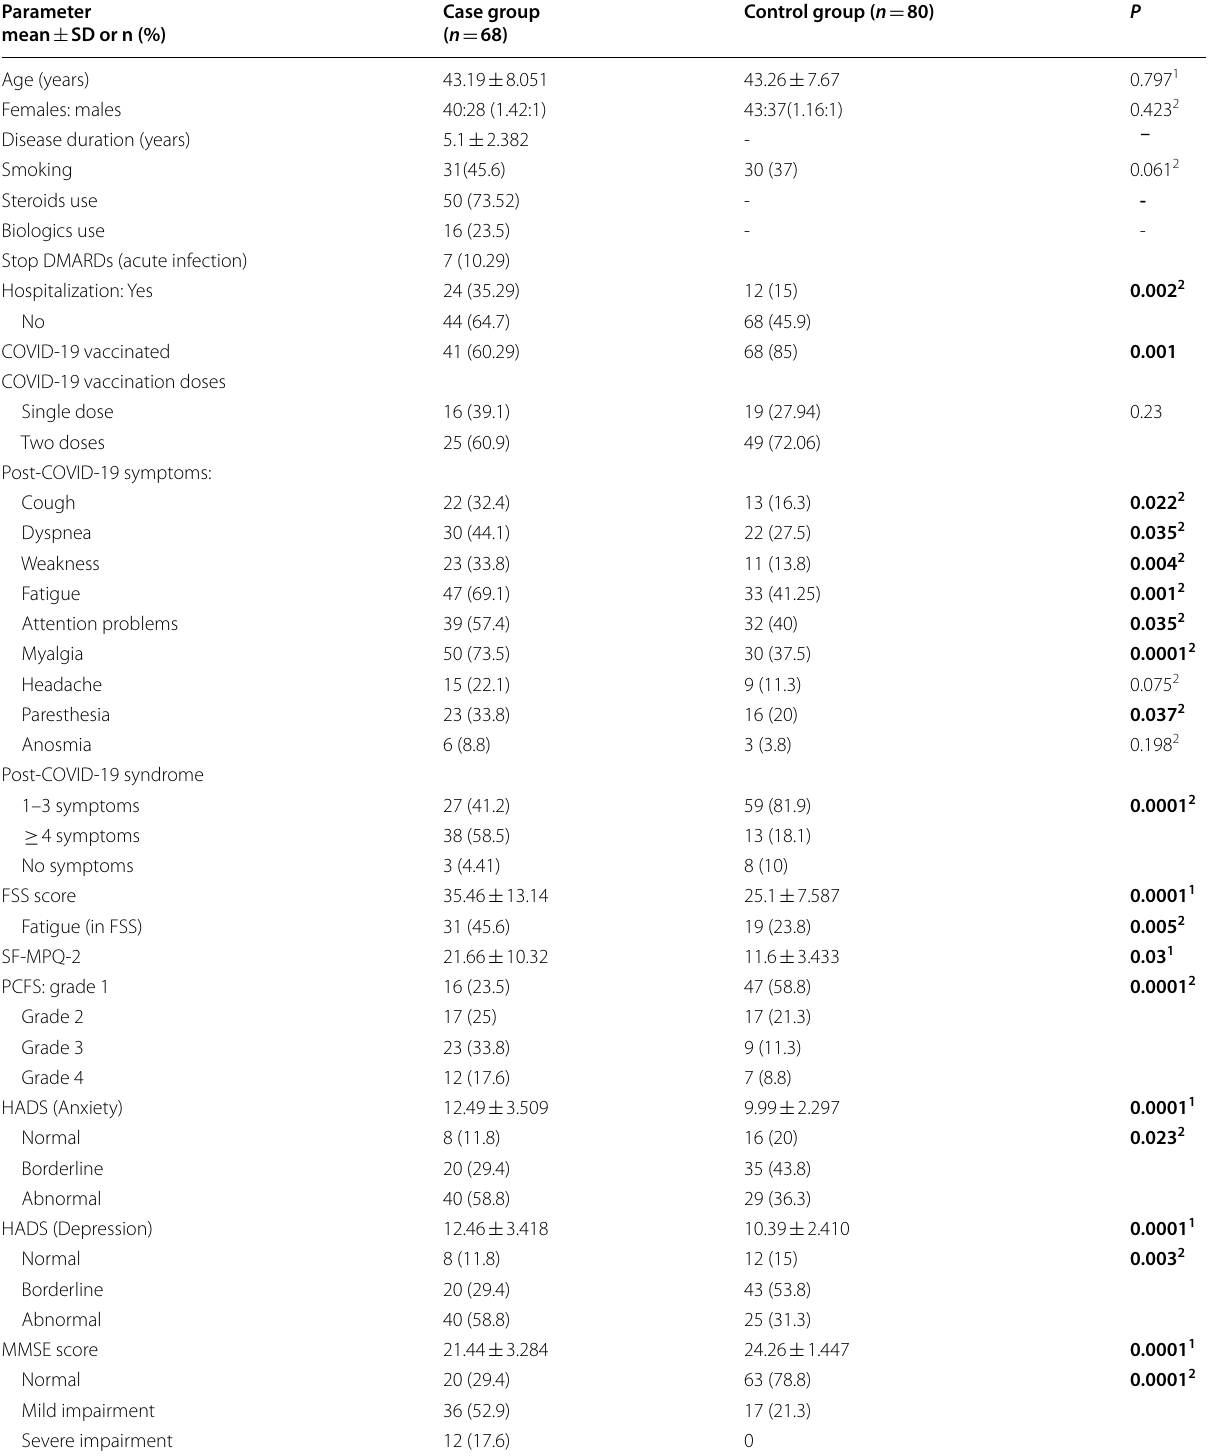
Table 1 Clinical and demographic characteristics of both